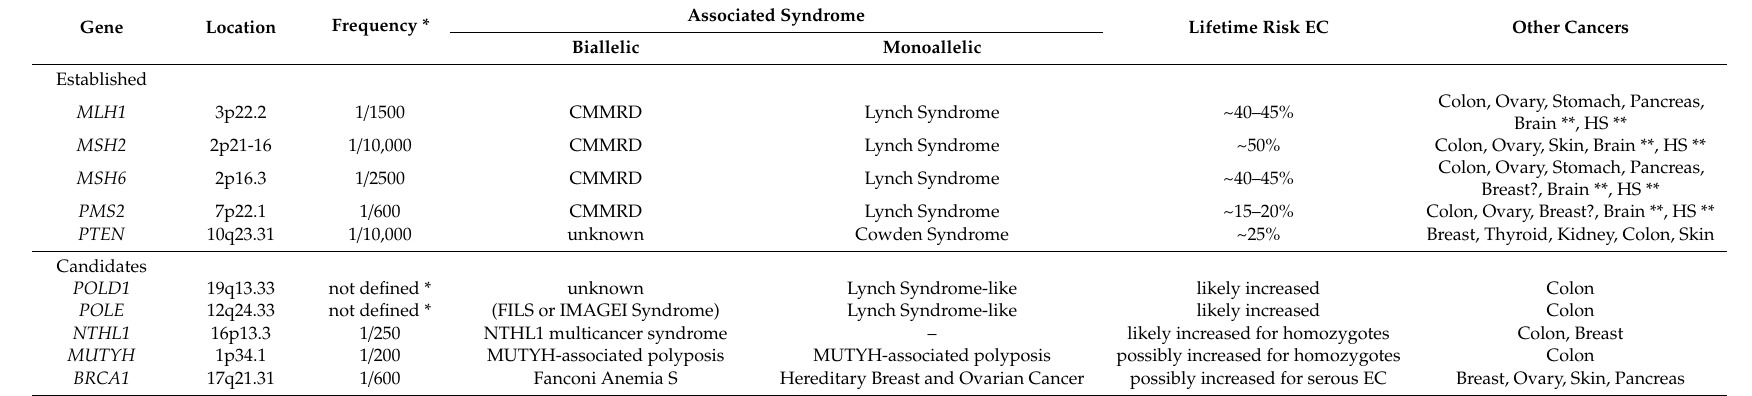
Table 1. Established and candidate endometrial cancer risk